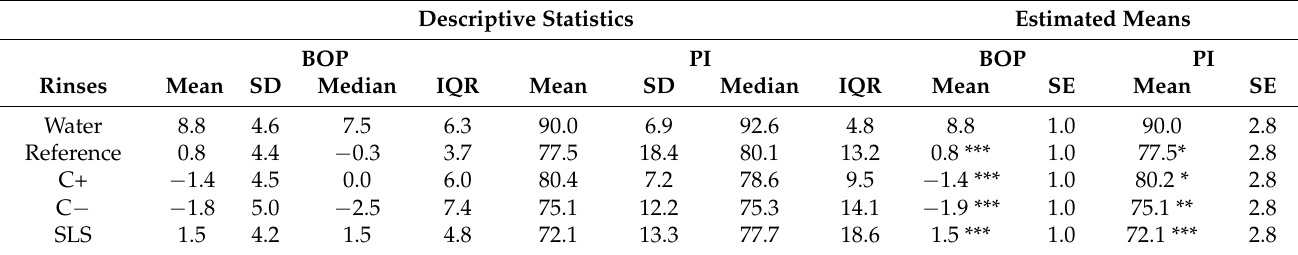
Figure 5. Boxplots of estimated means (plaque indices) of each test toothpaste and the water application of all the subjects ( n = 20, colored) in percentage (%), showing median percentages, 25th and 75th quartiles, standard deviation, and outliers. The plaque indices of both water runs, which were performed prior to the test phase, were averaged. C+ = enzyme-containing toothpaste with Citrox; SLS = SLS-containing reference toothpaste; placebo = reference toothpaste without SLS and without enzymes; C − = enzyme-containing toothpaste without Citrox; control = mean values after water rinsing. Table 3. Descriptive mean values with standard deviation (SD), median, and interquartile ranges (IQR), as well as estimated mean values and standard error (SE) of all toothpastes and rinsing with water for both bleeding on probing (BOP) and plaque indices (PI) changes (% points; difference of the baseline and post-rinse values). The statistically significant differences in toothpaste slurries to water are marked with stars; * 0.05 > p ≥ 0.01, ** 0.01 > p ≥ 0.001, *** p <